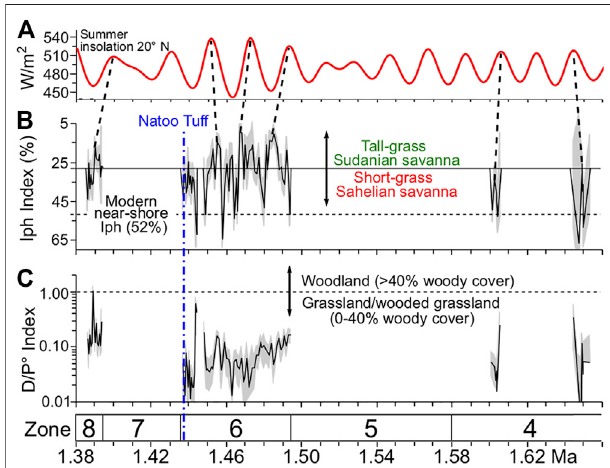
FIGURE 6 | Phytolith Iph (aridity) and D/P ° (tree cover) indices. Gray shading represents bootstrapped 95% con fi dence intervals. The vertical blue dashedlinemarksthepositionoftheNatooTuffintheWTK13core,linkingthe Nariokotome Boy site (NK3) to the core. (A) Summer insolation for 20 ° N (Laskar et al., 2004). (B) Iph index with inverted y-axis. Solid horizontal reference line set at 27.8%, which separates mesic tall-grass Sudanian savanna from xeric short-grass Sahelian savanna (Novello et al., 2017). Dashed horizontal line denotes the average modern Lake Turkana Iph value. Dashed vertical lines link possible tie points between peaks in insolation and peaks in phytoliths indicative of mesic C 4 tall-grasses (C) D/P ° tree cover